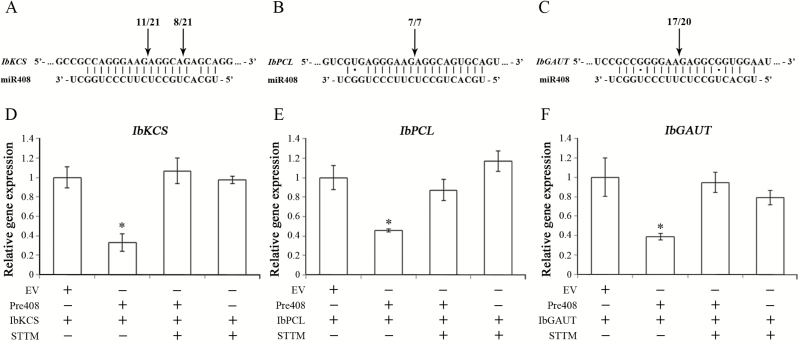
Validations of miR408 target genes by RACE and Agrobacterium-mediated transient assays. The potential cleavage sites of miR408 on three targets, IbKCS (A), IbPCL (B), and IbGAUT (C), in sweet potato were analyzed by 5'-RLM-RACE and 3'-PPM-RACE. The arrows indicate the positions of the cleavage sites, and clone frequencies are indicated by the numbers. In addition, Agrobacterium-mediated transient expression assays of miR408 and its targets, IbKCS, IbPCL, and IbGAUT, in tobacco leaves. Tobacco leaves were infiltrated with agrobacteria with a vector containing the miR408 targets, IbKCS (35S:IbKCS), IbPCL (35S:IbPCL), or IbGAUT (35S:IbGAUT), and with a vector containing the empty vector (EV), the miR408 precursor (Pre408), the short tandem target mimic of miR408 (STTM), or miR408 plus STTM. The expression of IbKCS (D), IbPCL (E), and IbGAUT (F) in tobacco leaves was then analyzed by qRT-PCR, and normalized to the levels of NPTII expression. The ratios relative to the plants with empty vector are shown as relative expression levels. Data are presented as means ±SD (n=4). The asterisks represent a significant difference by Student’s t-test (*P<0.05).